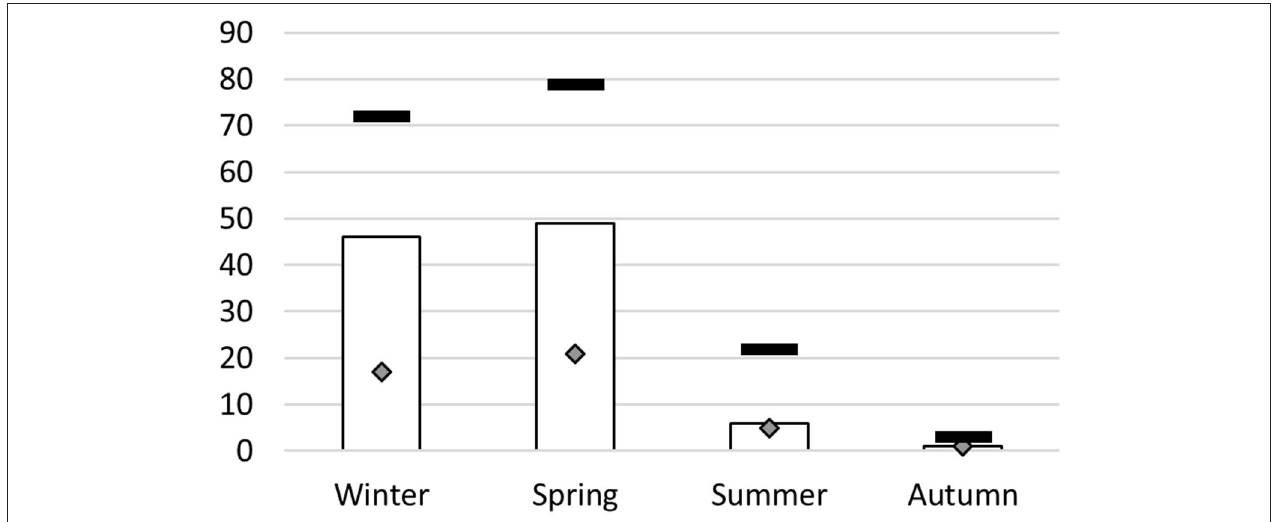
FIGURE 1 | M. bovis detection by real-time PCR according to season of sampling. X-axis, season of BALF collection; y-axis, number of calves that tested positive in real-time PCR (target M. bovis ) (white bars), total number of calves sampled for each season (black dashes) and number of calves from which clones were isolated (diamonds).